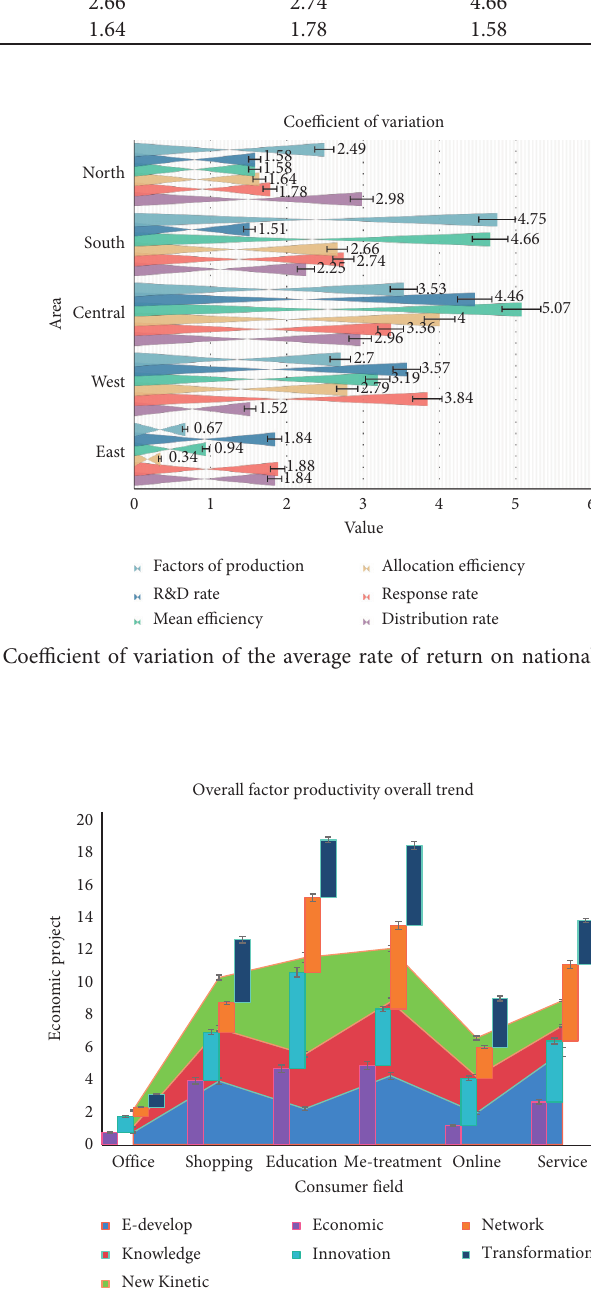
Figure 13: Overall factor productivity overall